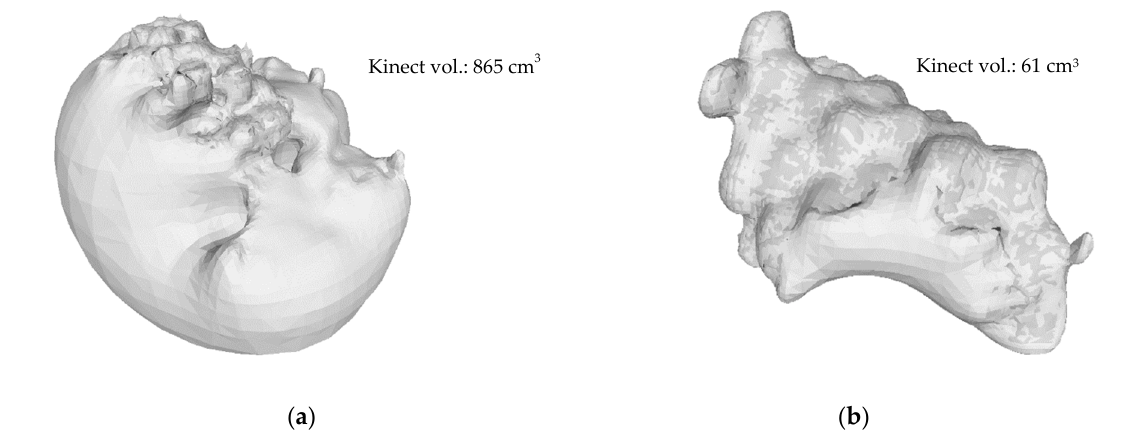
Figure 14. Illustration of Screened Poisson Surface Reconstruction . The reconstructed bunch (circled in red—Figure 13b) with the incorrect volume ( a ), and an example of a reconstructed bunch of the correct volume ( b ).